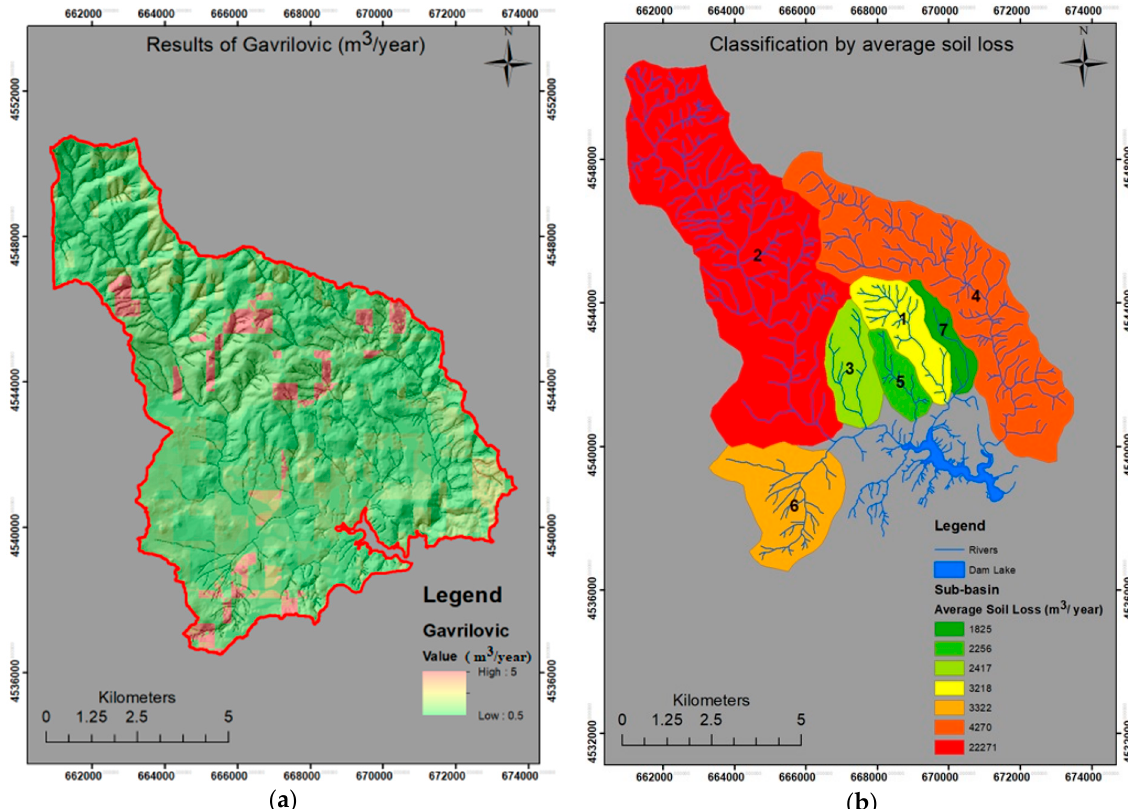
Figure 3. Calculation of sediment discharge by: ( a ) Gavrilovic method and ( b ) classification by average soil.